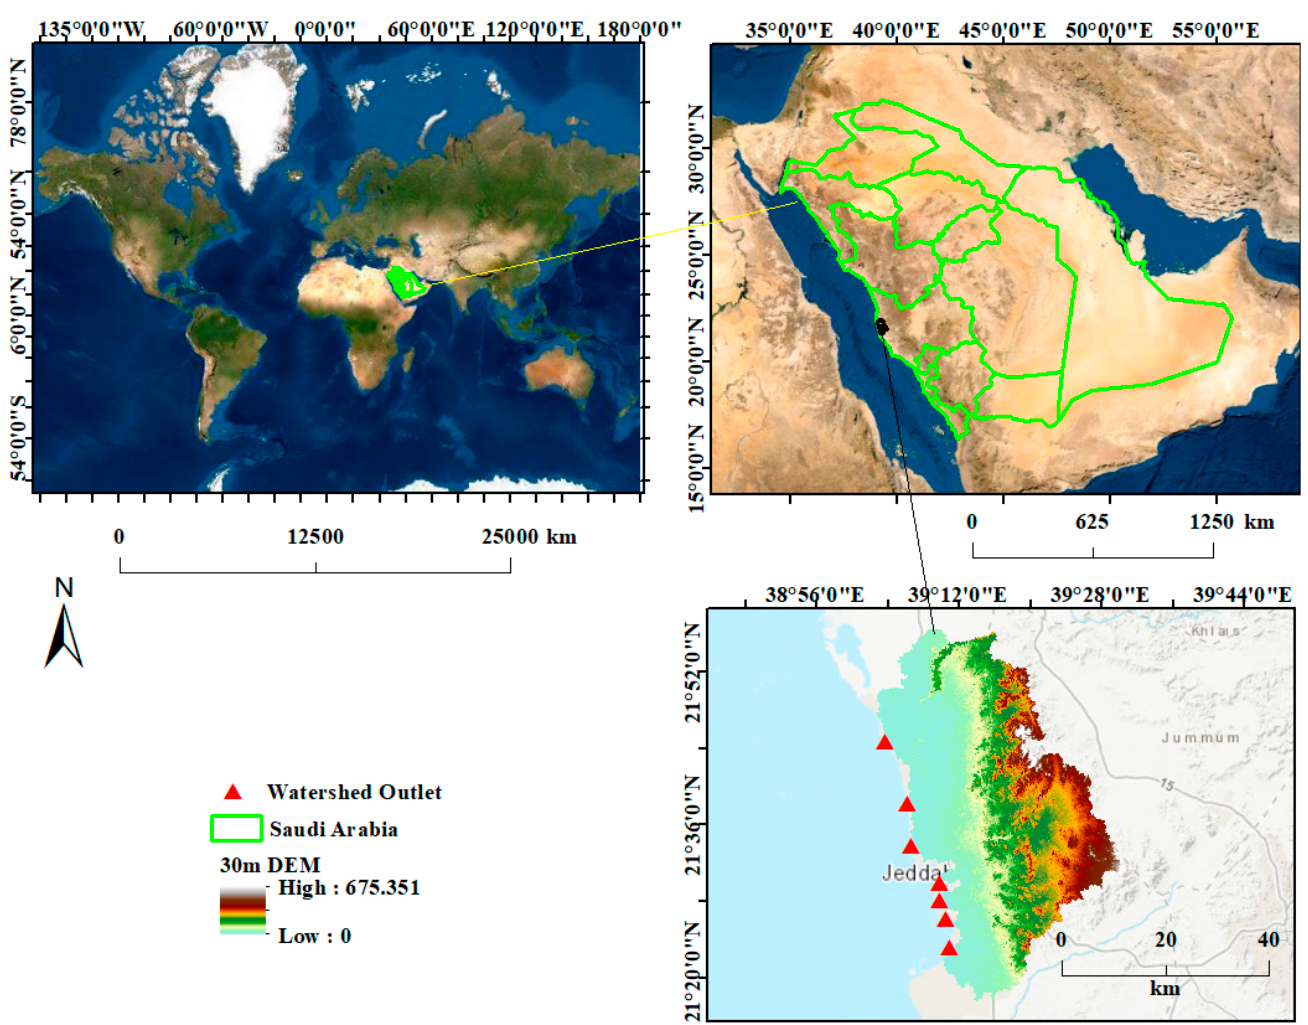
Figure 1. Study area employed in this